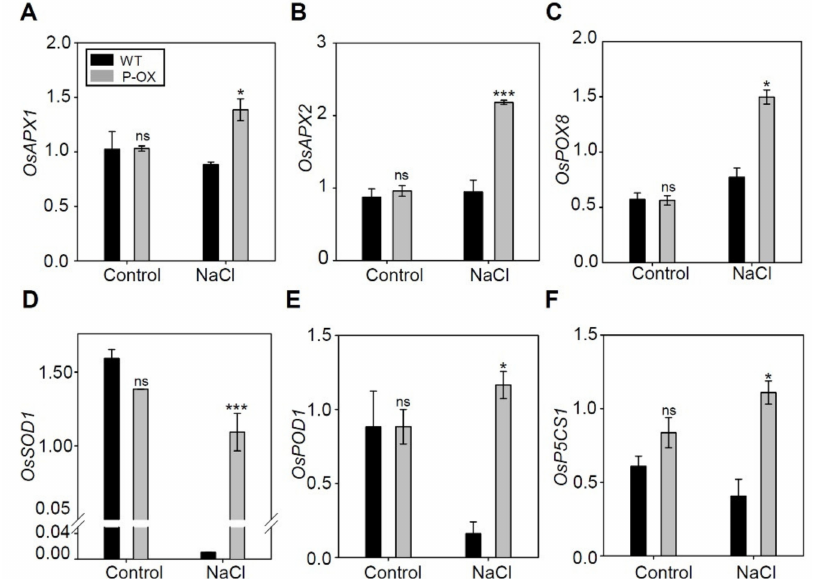
Figure 7. Expression of genes involved in antioxidant activity in the roots of WT and OsEXPA7 -OX rice plants under salt stress. ( A – F ) The expression of genes involved in antioxidant activity was investigated by qRT-PCR. OsAct11 was used as a control. OsAPX1 (ascorbate peroxidase 1) ( A ), OsAPX2 (ascorbate peroxidase 2) ( B ), OsPOX8 (peroxidase 8) ( C ), OsSOD1 (superoxide dismutase 1) ( D ), OsPOD1 (peroxide dismutase 1) ( E ), and OsP5CS1 ( F ) were tested. qRT-PCR analysis was performed with at least three biological replicates. Asterisks indicate a statistically significant di ff erence, as determined by the Student’s t -test (*** p < 0.001, * p < 0.05). ns, not